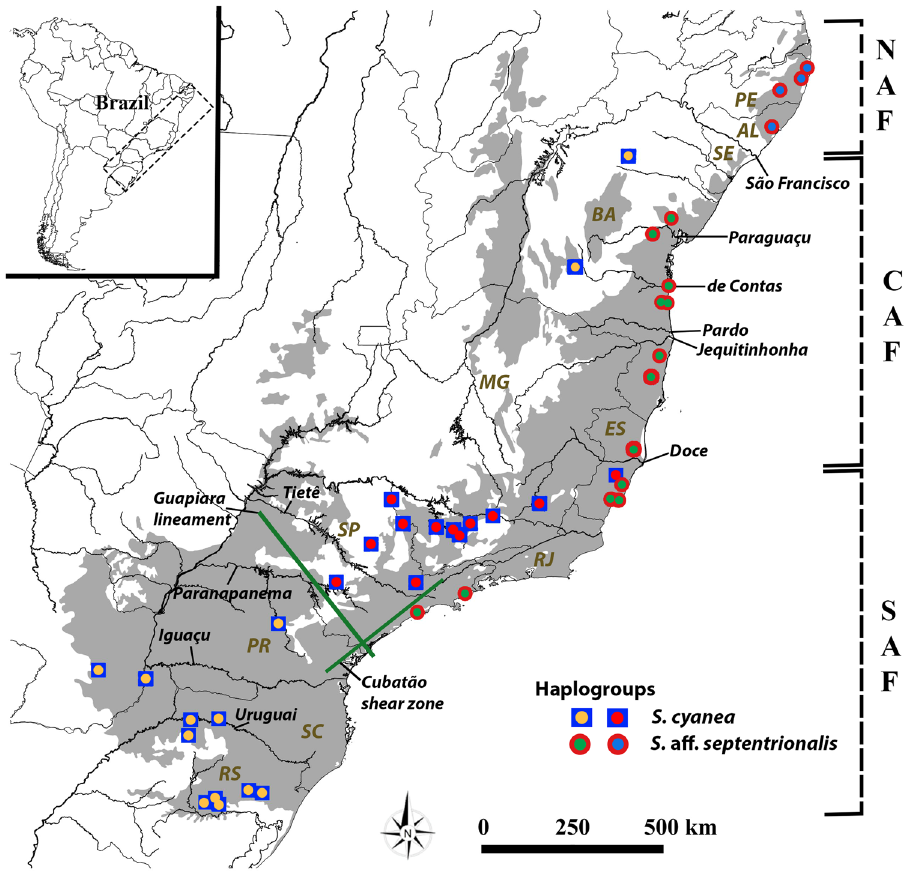
Figure 1. Map showing collection sites in the present study (see also Supplementary Table S1). Atlantic Forest (AF) is indicated in light grey, state borders in grey and main rivers (São Francisco, Paraguaçu, de Contas, Pardo, Jequitinhonha, Doce, Tietê, Paranapanema, Iguaçu and Uruguai) in black. Four haplogroups are indicated (see text for details). Schematic subdivision of the AF along its geographical range: North Atlantic Forest (NAF), Central Atlantic Forest (CAF) and Southern Atlantic Forest (SAF). Brazilian states: Rio Grande do Sul (RS), Santa Catarina (SC), Paraná (PR), São Paulo (SP), Rio de Janeiro (RJ), Espírito Santo (ES), Minas Gerais (MG), Bahia (BA), Sergipe (SE), Alagoas (AL) and Pernambuco (PE). Green lines represent areas of putative geographic barriers influencing S. cyanea distribution. The map was generated using the software Quantum-GIS v2.8 (Open Source Geospatial Foundation Project, Beaverton, OR, USA) (http://www.qgis.org/